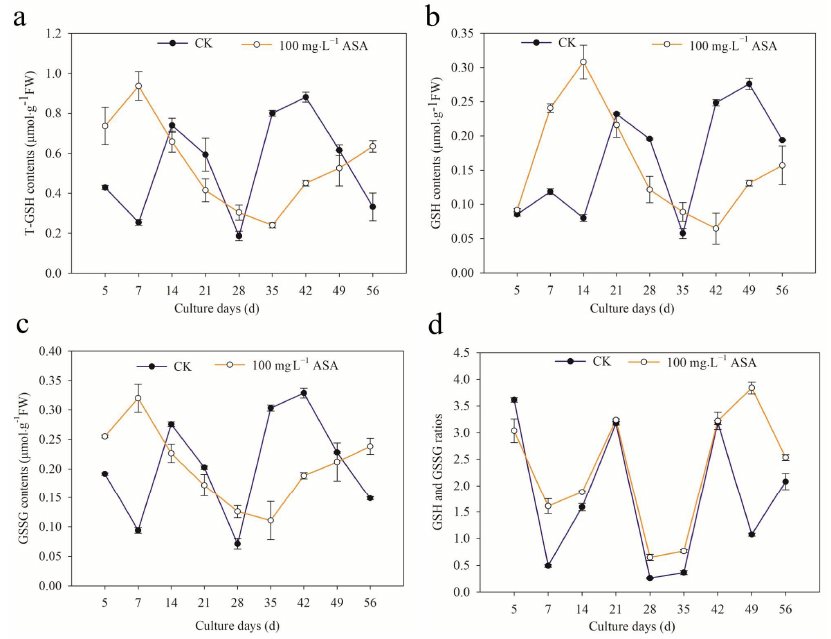
Figure 9. Effects of 0 and 100 mg · L − 1 ASA treatments on GSH synthesis during somatic embryogenesis of Fraxinus mandshurica provenance 3. The x -axis represents the culturing days, the y -axis represents the T-GSH content ( a ), GSH content ( b ), GSSG content ( c ), and GSH/GSSG ratio ( d ), and the error bar shows the standard error of the mean.